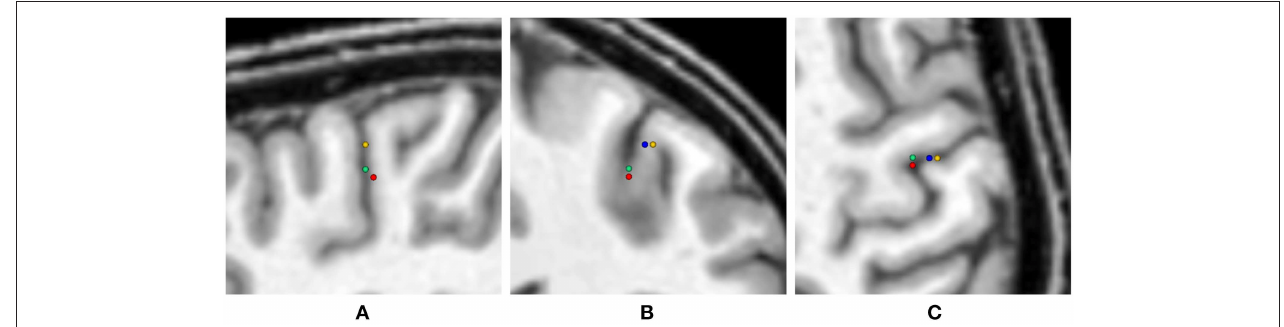
FIGURE 10 | Visualization of the source locations with maximal GoF for the uni- and multivariate distributions overlaid on the T1-MRI (blue - skin, green - skull, yellow - CSF, gray matter, white matter, red - multivariate). From left to right showing sagittal (A) , coronal (B) , and axial slice (C) . In the sagittal slice (A) the visualizations for skin and CSF, gray matter, and white matter are